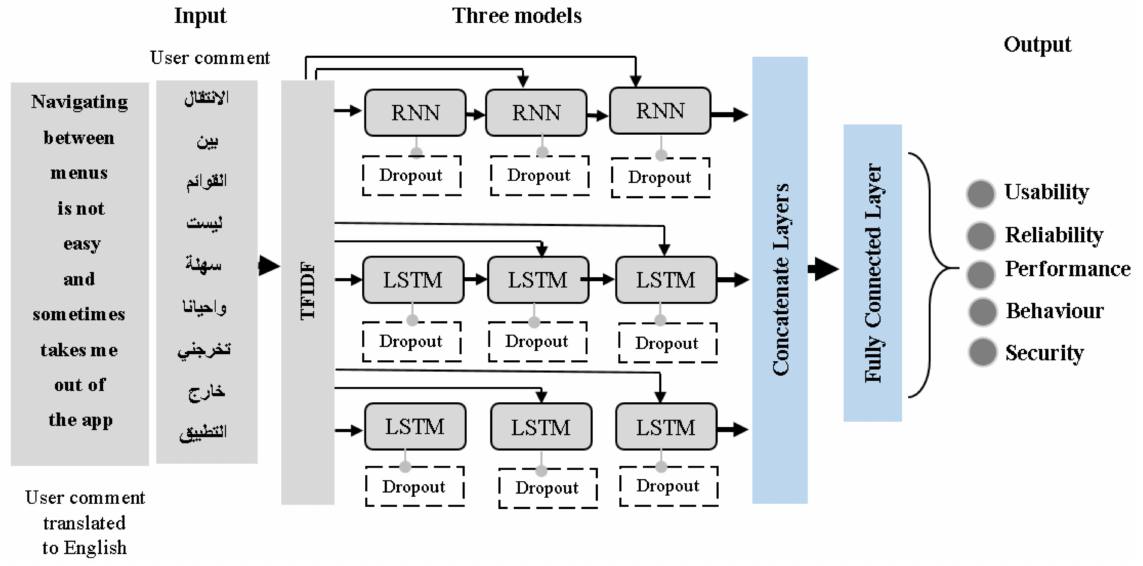
Figure 4. Proposed hybrid deep learning